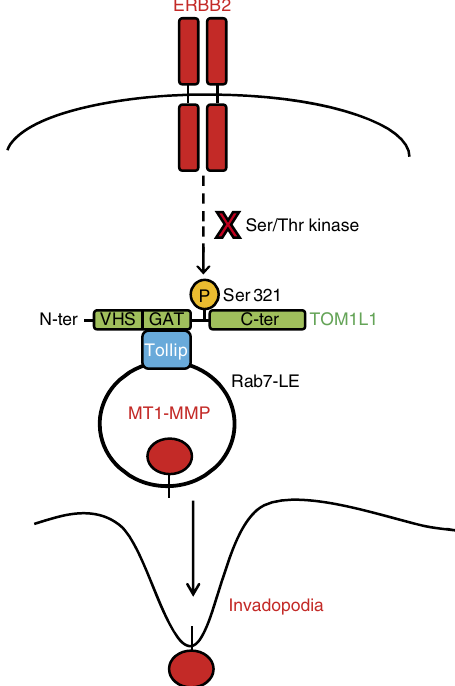
Figure 9 | A model for TOM1L1 invasive activity. ERBB2 indirectly induces TOM1L1 phosphorylation at Ser321 to promote association with TOLLIP in RAB-7/MT1-MMP-positive late endosomes and MT1-MMP trafficking to plasma membrane for cell